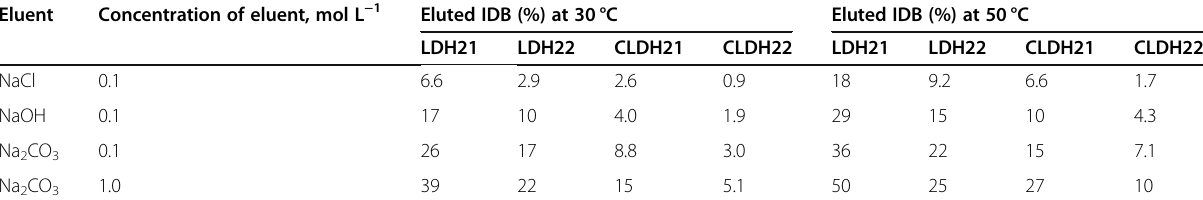
Table 6 Desorption study of IDB-loaded onto LDHs and CLDHs at 30 and 50 °C Eluent Concentration of eluent, mol L −